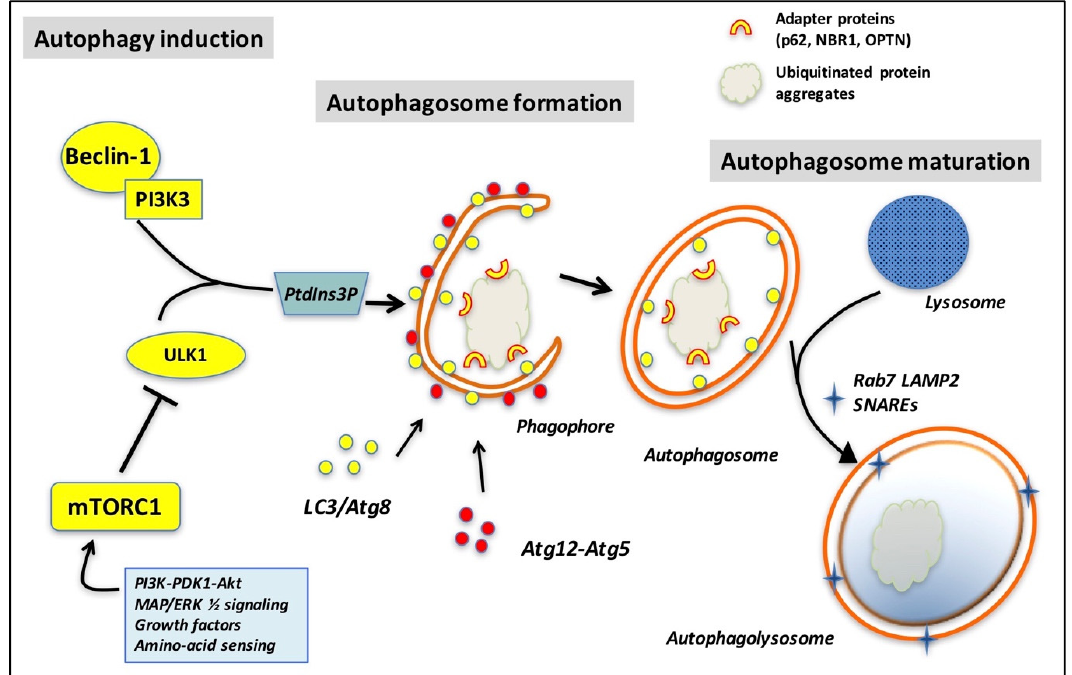
Figure 2. Basics of autophagy : autophagy starts at a membrane core assembly site, which requires